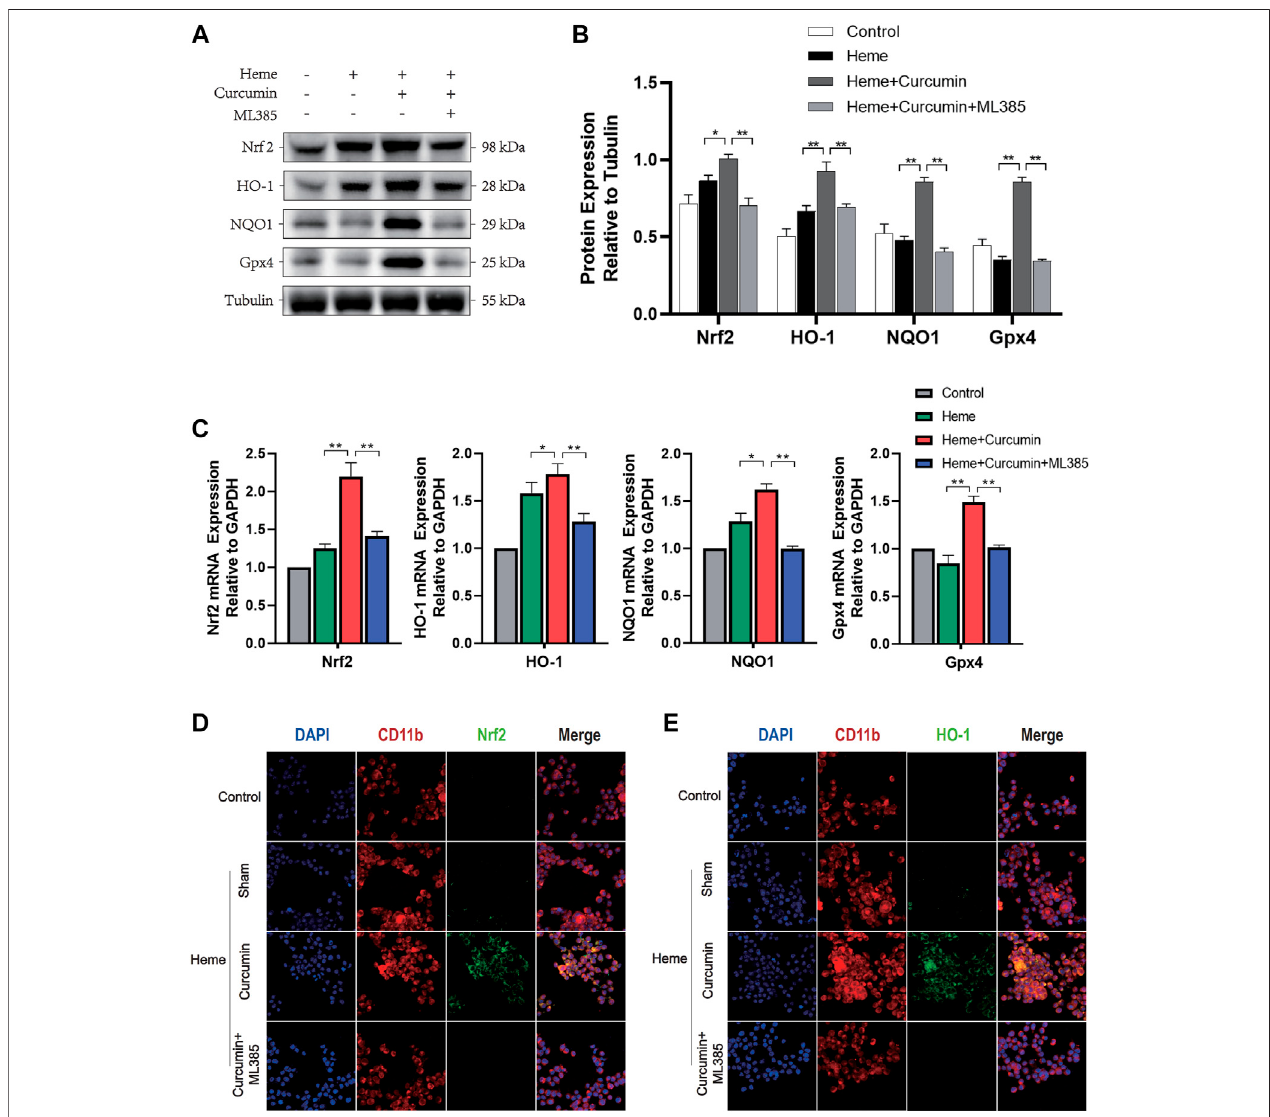
FIGURE 5 | Curcumin could activate the Nrf2/HO-1 pathway in rat primary microglia. (A) Western blot analysis of each group of primary microglia. (B) ImageJ software was used to further quantify the gray values of the western blot bands. (C) The expression of the Nrf2, HO-1, NQO1, and Gpx4 was detected using RT – qPCR and compared withthatofan internal reference gene(GAP). (D) The primary microglial membraneprotein CD11b waslabeled withTexas Red, and Nrf2 wasmarked by FITC. (E) Theprimary microglialmembraneprotein CD11bwaslabeledwithTexasRed, andHO-1wasmarkedbyFITC. Thedataareshownasthemeans±SDof n =3samples/groupandatleastthreeindependentexperimentswereperformed.Thestatisticalanalyseswereconductedusingthetwo-wayANOVA.*, p < 0.01and**, p < 0.01.